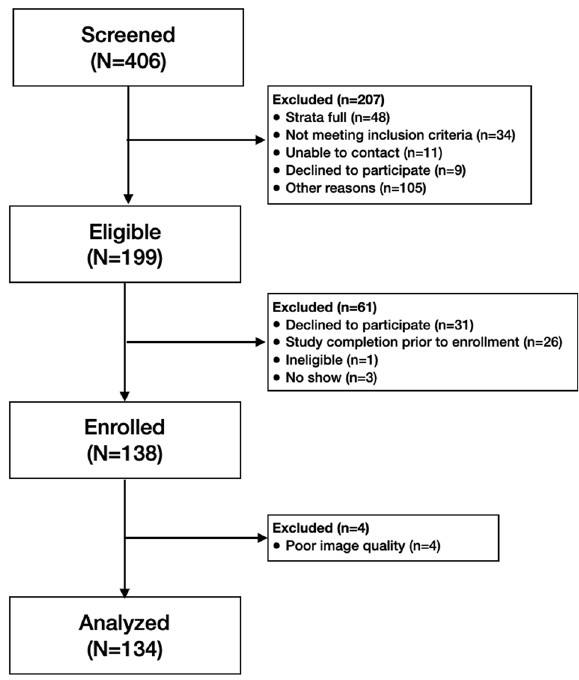
Fig. 1 Consort Body composition